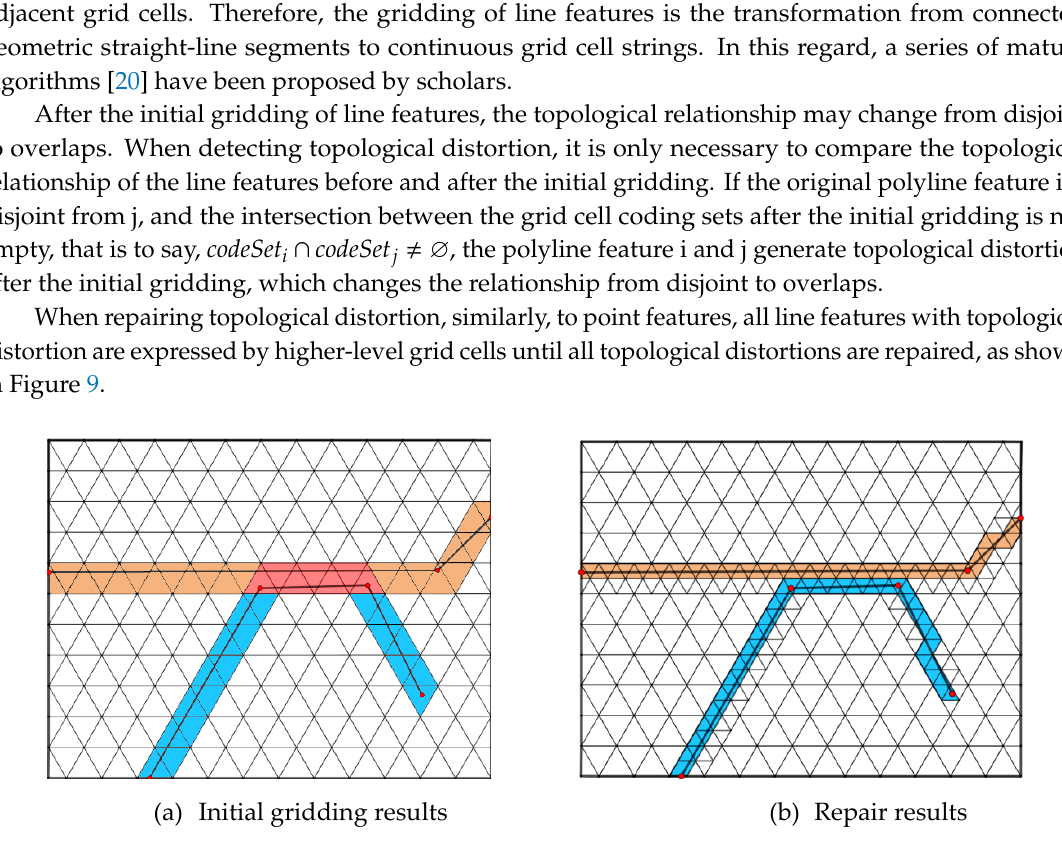
Figure 9. Repair of topological distortion of line features.